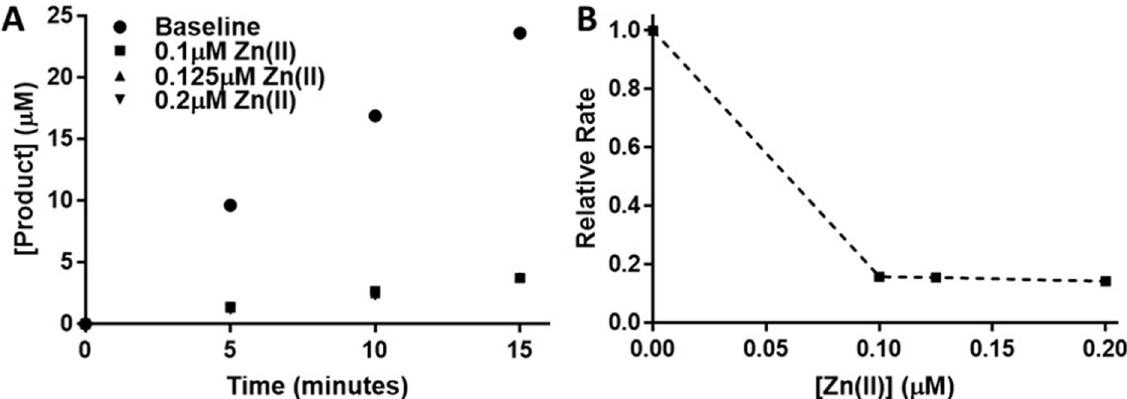
Fig 2. HDAC3:NCOR2 Inhibition by Zn(II). HDAC3:NCOR2 (2 μ M final concentration) was incubated with various concentrations of Zn (II) for one hour on ice and then diluted to 50 nM and assayed using the Fluor de Lys assay (panel A). Assay buffer was composed of 25 mM Tris, pH 8, and 10 mM KCl. The baseline sample buffer contained 500 μ M EDTA and no added Zn(II). Observed rates at each concentration of Zn(II) were normalized to the baseline rate (panel B).